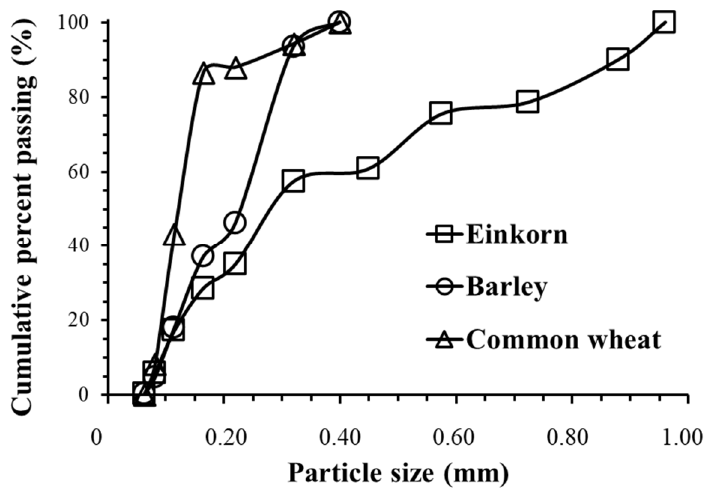
Figure 3. Cumulative distribution of particle size of einkorn, barley and common wheat flours.